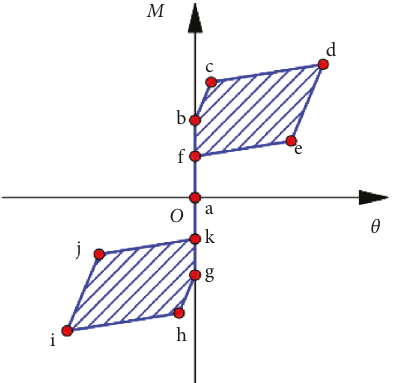
Figure 3: Typical hysteretic relation curve between overturning moment ( M ) and rotation angle θ .